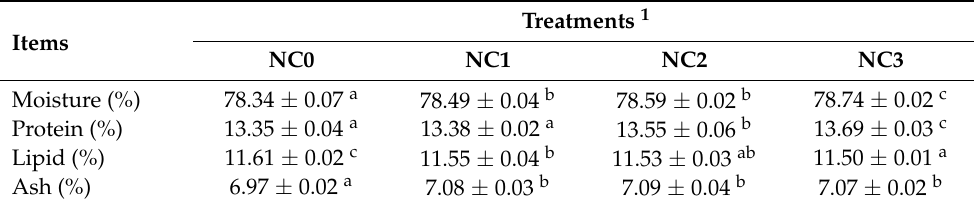
Table 3. Body composition of Red Tilapia ( Oreochromis sp.) after 56-day-feeding